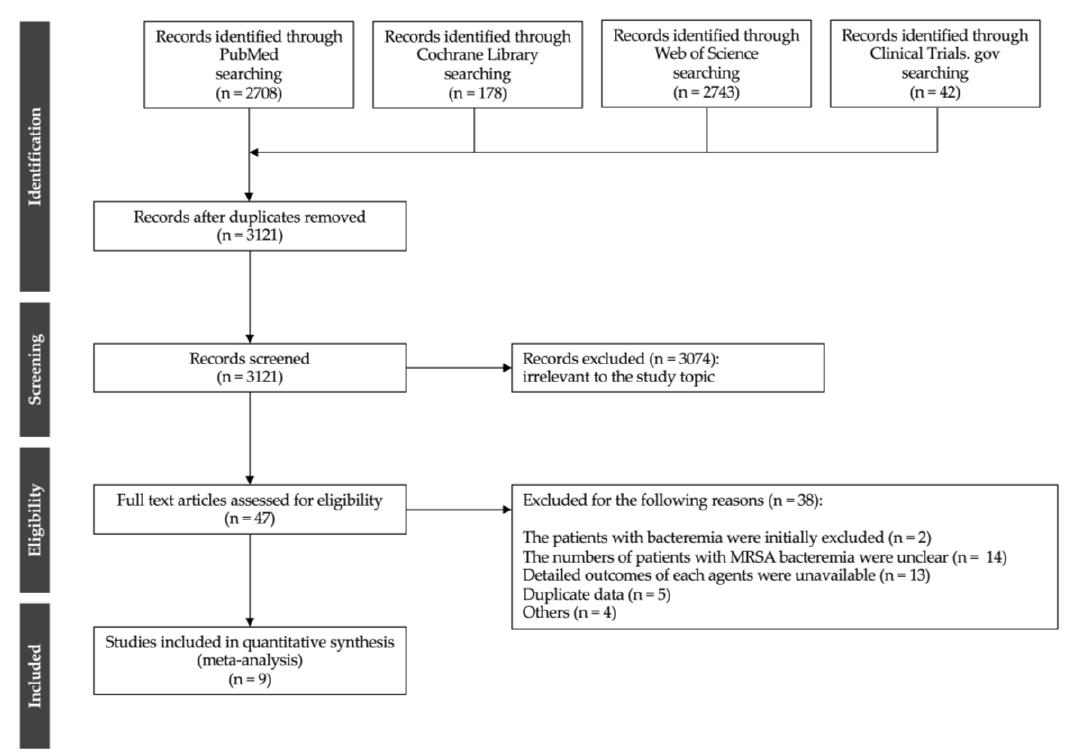
Figure 1. Flow chart of the study selection process.